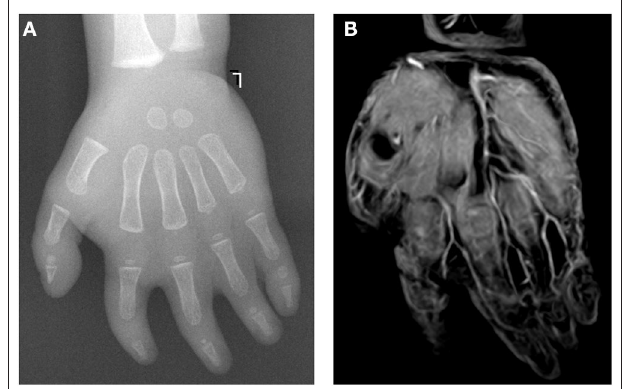
Frontiers in Pediatrics |